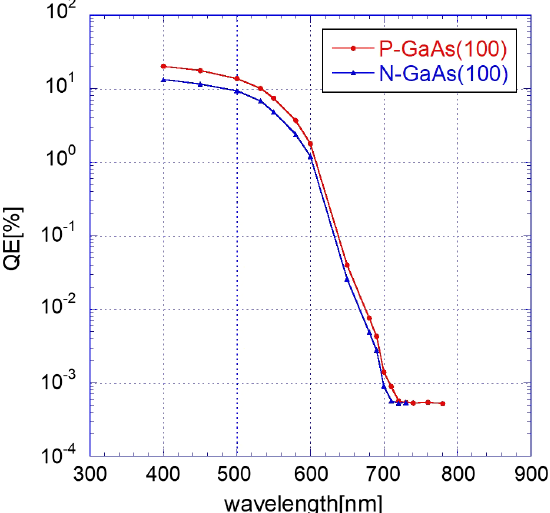
FIG. 3. Spectral response for a CsK 2 Sb photo-cathode, with red circles and blue triangles for the p -GaAs(100) and n -GaAs(100) substrates, respectively. The measurement limit of photo-current is 10 nA.